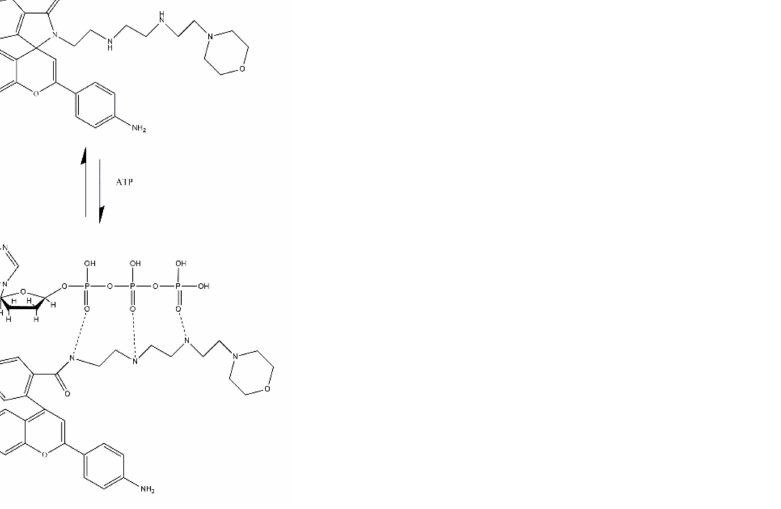
Figure 44. The proposed sensing mechanism of the prepared sensor (Table 3, No. 6) for ATP [95]. Apart from ATP, the rhodamine-based acid phosphatase (ACP)-detection sensor was reported based on the IFE between oxidized 3,3 (cid:48) ,5,5 (cid:48) -tetramethylbenzidine (oxTMB), and rhodamine B [96]. Specifically, the fluorescence of rhodamine B was quenched by oxTMB, owing to spectral overlap between the emission of rhodamine B and the absorption of oxTMB. oxTMB was reduced by ascorbic acid, generated from ACP-inducing hydrolysis of 2-phospho-L-ascorbic acid trisodium salt. Thus, the internal filtering effect between rhodamine B and oxTMB was inhibited, realizing the determination of ACP. Sensor Nos. 8–12 (Table 3) [97–101] were applied for anion detections. Among these, sensor No.8 (Table 3) was a Si-rhodamine-based sensor (SiNH) that showed a nanoscale re- sponse after capturing amphiphilic copolymers named mPEG-DSPE [97]. The amphiphilic mPEG-DSPE improved the water solubility of the prepared sensor which was applied to real-time analysis of endogenous ONOO − in living cells (Figure